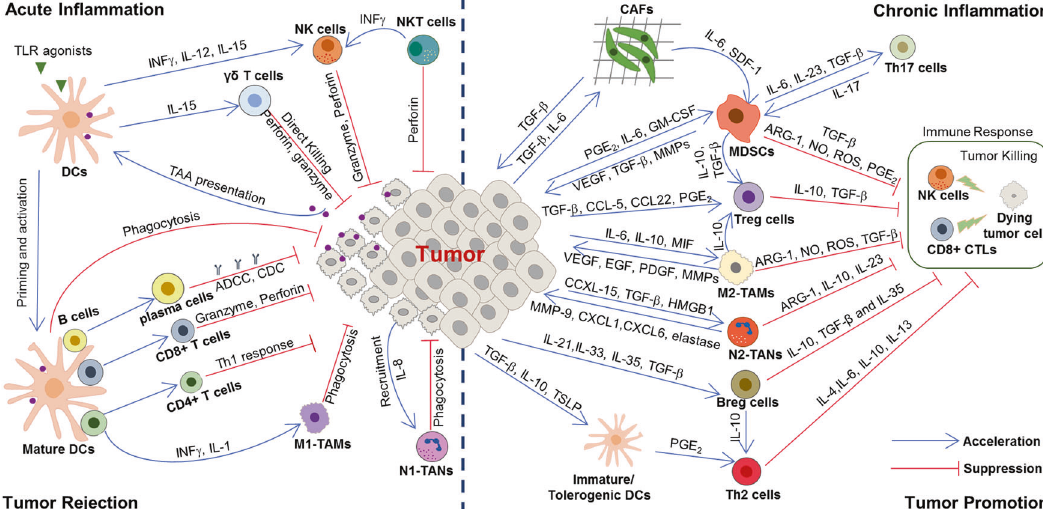
Fig. 3 The relationship between in fl ammation and cancer development. During acute in fl ammatory responses (left panel): after tumor antigen uptake or activation by TLR agonist, mature DCs can regulate anti-tumor immune responses by inducing in fl ammatory responses via multiple mechanisms, such as cross-presenting the tumor antigens and priming tumor-speci fi c CD8 + T cells, polarizing immune cells toward tumor suppression (e.g., M1 polarization of TAMs), recruiting NK cells which can sustain T-cell responses. However, if the acute in fl ammatory reaction does not resolve in time, it subsequently transforms into chronic in fl ammation (right panel). In this microenvironment, cancer cells can not only hijack DCs to prevent TAA presentation, but also recruit a large number of immunosuppressive cells (e.g., MDSCs, Treg cells, Breg cells, M2-TAMs, N2-TANs, and Th2 cells) by secreting various cytokines, chemokines, and in fl ammatory mediators. In turn, these immunosuppressive cells provide a rich proangiogenic and pro-tumoral microenvironment, and prevent the innate immunity and T-cell induction of CRC in mice. 265,266 IBD-associated colon cancer shows different DNA methylation level compared with sporadic colon diseases have also been reported to contribute to carcinogenesis. cancers. 267 Besides, a research using the single-cell multiomics For instance, infection with H. pylori was demonstrated to lead to gastritis and stomach cancer. 269,270 IBD was not suf fi cient to sequencing of human CRC has revealed that epigenetic inheri- tance plays an important regulatory role in the occurrence and induce CRC in the absence of intestinal microbiota or microbial development of CRC. 268 products, 271 and the use of a common antimicrobial additive